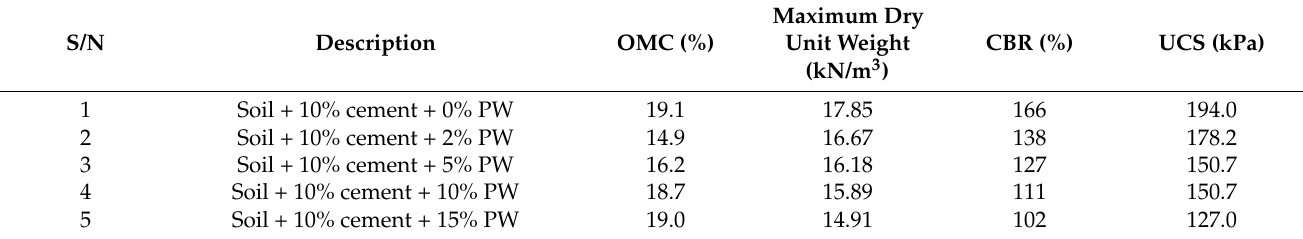
Table 3. Effects of PW on the strength parameters of cement-stabilised